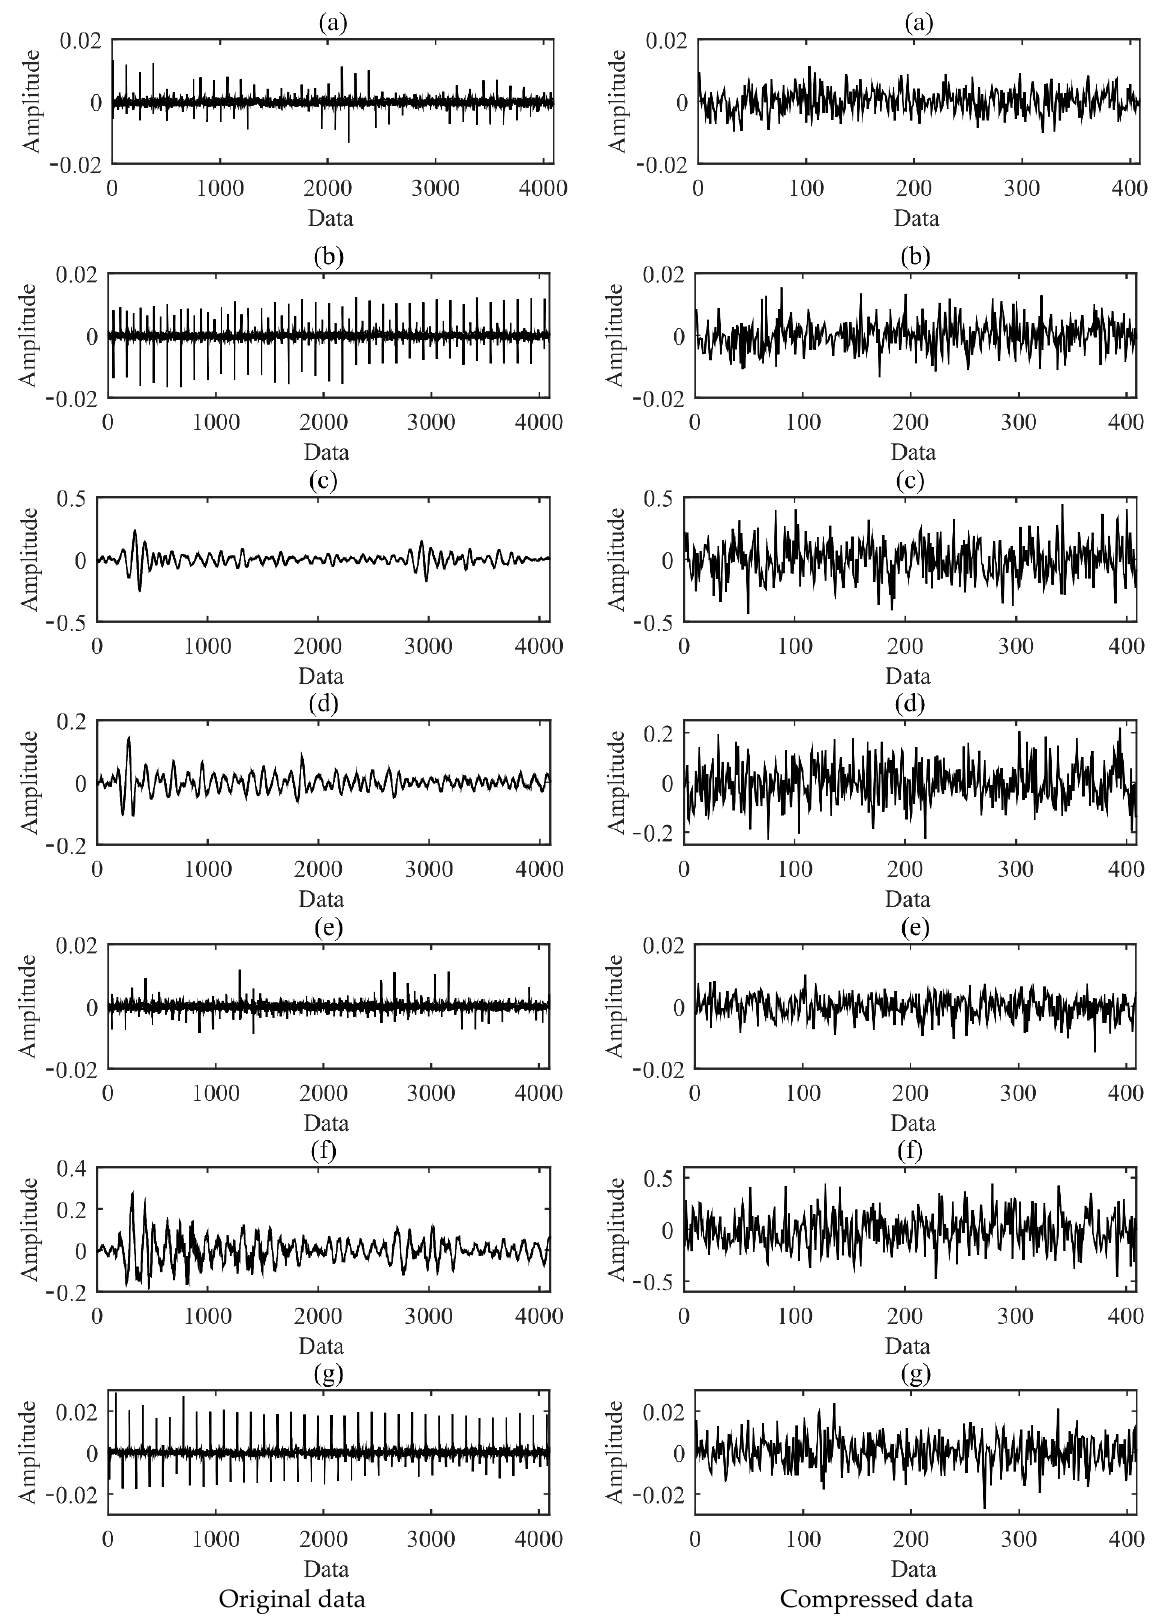
Figure 6. Time waveform. ( a ) Normal, ( b ) sun gear tooth root crack, ( c ) sun gear multi-tooth surface wear, ( d ) sun gear single tooth surface wear, ( e ) planetary gear tooth root crack, ( f ) planetary gear multi-tooth surface wear, ( g ) planetary gear single tooth surface wear.